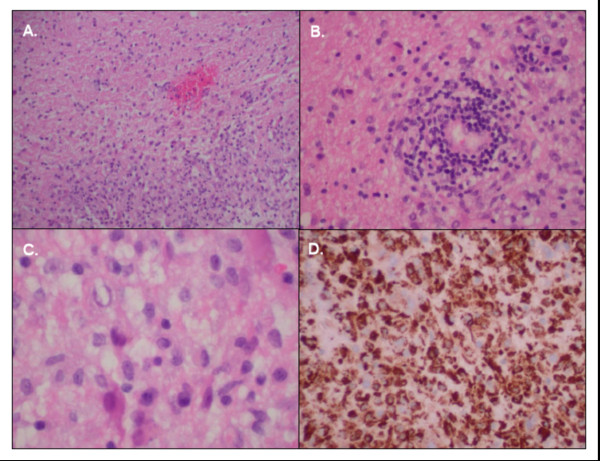
Left occipital brain biopsy performed on 15 March 2009. A) Hematoxylin and eosin (H&E) stain (100×) showing a sharp border between relatively normal neuropil inferiorly and a paler area of gliosis representing a lack of myelin superiorly. B) H&E stain (200×) showing a peri-vascular cuff consisting of lymphocytes and histiocytes. C) H&E stain (400×) showing an inflammatory infiltrate rich with histiocytes. D) Immunoperoxidase stain (200×) for CD68 macrophages showing strong positivity in areas of gliosis. The final pathological diagnosis was gliosis and reactive changes consistent with demyelinating disease. The findings were negative for lymphoma. An immunostain for herpes simplex virus (HSV) was also negative. Other immunohistochemistry stains were as follows: B cell marker CD20 was positive in a few B cells, T cell marker CD3 was positive for several T cells, B cell marker CD79 was positive in a few B cells, and proliferation marker Ki-67 was low at 3%.